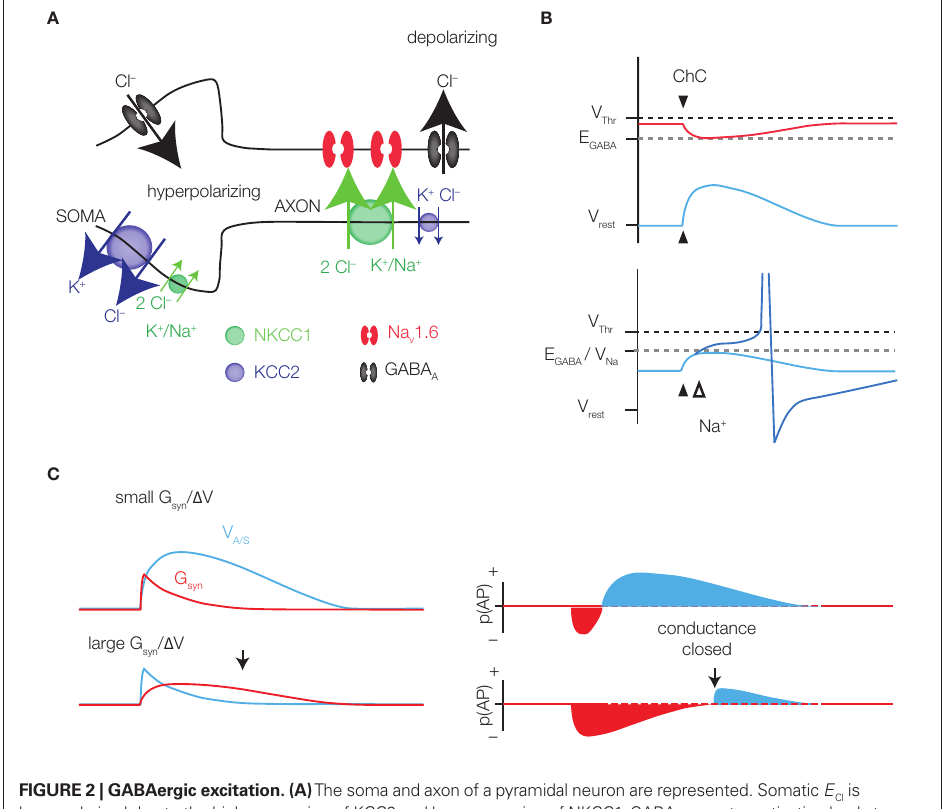
FiGure 2 | GABAergic excitation. (A) The soma and axon of a pyramidal neuron are represented. Somatic E is Cl hyperpolarized due to the high expression of KCC2 and low expression of NKCC1. GABA receptor activation leads to A hyperpolarization, or no net flux of ions (shunting). At the AIS, the expression of cation chloride transporters is reversed, favoring chloride efflux and depolarization upon GABA channel opening. Low-threshold NaV1.6 sodium channels may be A activated by the depolarization, enhancing the excitatory effect. (B) Although depolarizing, a GABAergic event may be inhibitory, due to the conductance effect of channel opening. However, the inhibitory conductance effect (red) decays more quickly than the excitatory membrane potential change (blue), providing at least some window of excitation (right panel, bottom). The strength and duration of excitation (blue) and inhibition (red), denoted here as spike probability (p(AP)), will depend on the magnitude of the conductance effect relative to the change in membrane potential. (C) The ChC synapse is expected to be hyperpolarizing during high activity periods (red) and depolarizing under resting conditions. Because AIS E is in the range of Na + channel activation, some depolarizations may be enhanced by sodium currents GABA (bottom